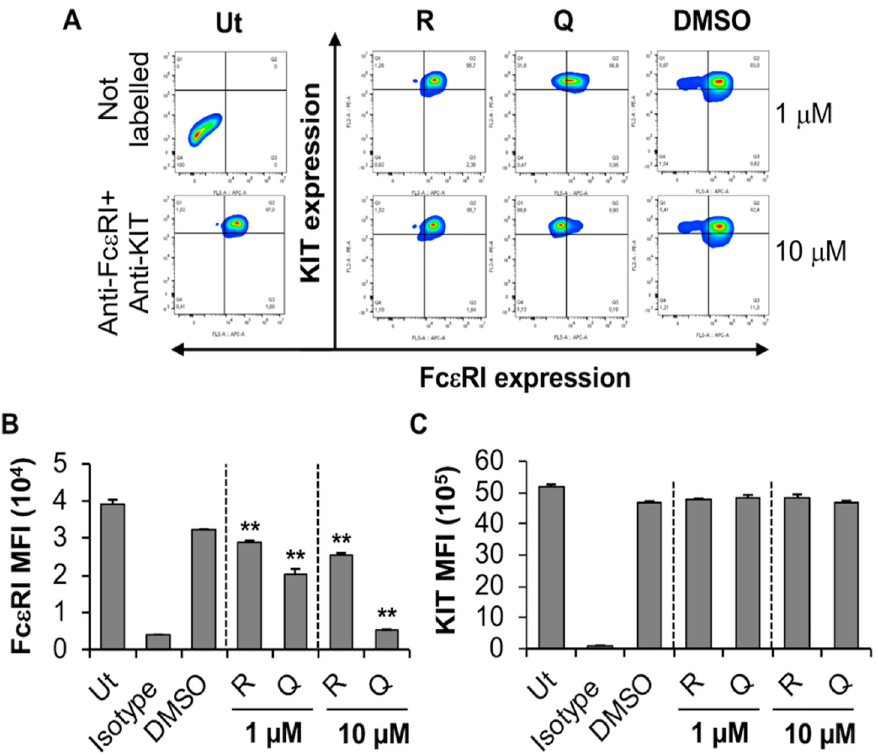
Figure 3. Effects of resveratrol and quercetin on Fc ε RI and KIT expression by BMMC. ( A ) BMMC were treated with 1 or 10 µ M quercetin (Q), resveratrol (R) or DMSO for 24 h followed by flow cytometry analysis. Ut represents untreated BMMC. Fc ε RI versus KIT expression contour plots were generated relative to the untreated unstained sample shown on the left-hand side panel. ( B , C ) Mean fluorescence intensity (MFI) of Fc ε RI and KIT expression by BMMC treated as in A. n = 3. p values < 0.01 (**) are relative to DMSO control.